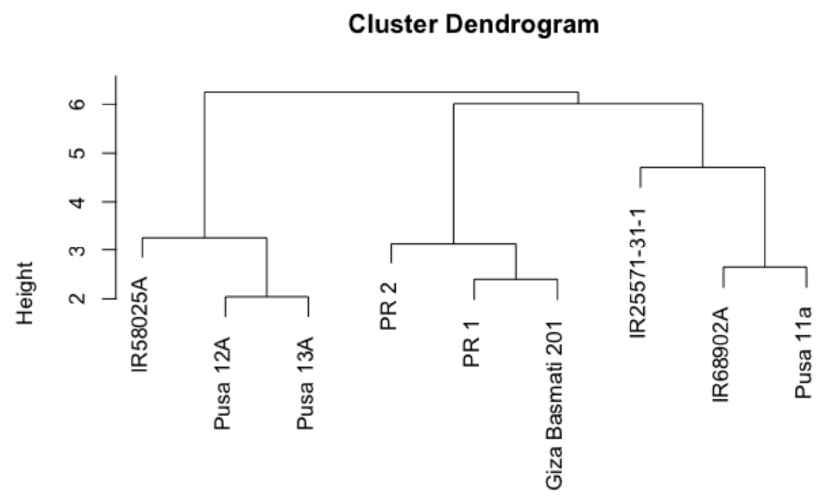
Figure 1. UPGMA dendrogram analysis of aroma cytoplasmic male sterile (CMS) and Restorer lines based on the morpho-logical data of their yield component characteristics. The mean performances of the male and female lines and their hybrid combinations